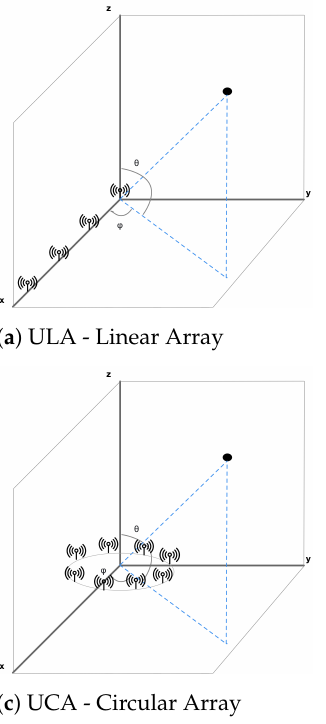
Figure 7. AoA and AoD radiogoniometry techniques require antenna arrays, whose common shapes are circular, rectangular, and linear. Every model of the array allows obtaining information concerning elevation and azimuth. Anyhow, rectangular and circular ones afford more further steady azimuth